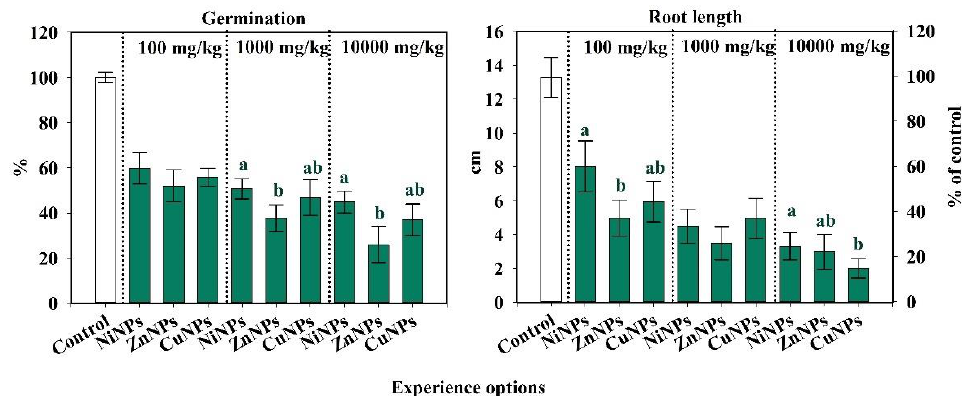
Figure 3. Change in germination rate and root length of Cambisols by CuNPs, NiNPs, and ZnNPs pollution, % of control. Note: Different letters indicate significant differences ( p < 0.05) between the content of nickel, zinc, and copper nanoparticles at the same dose of their introduction into the soil, obtained as a result of the Student’s test.